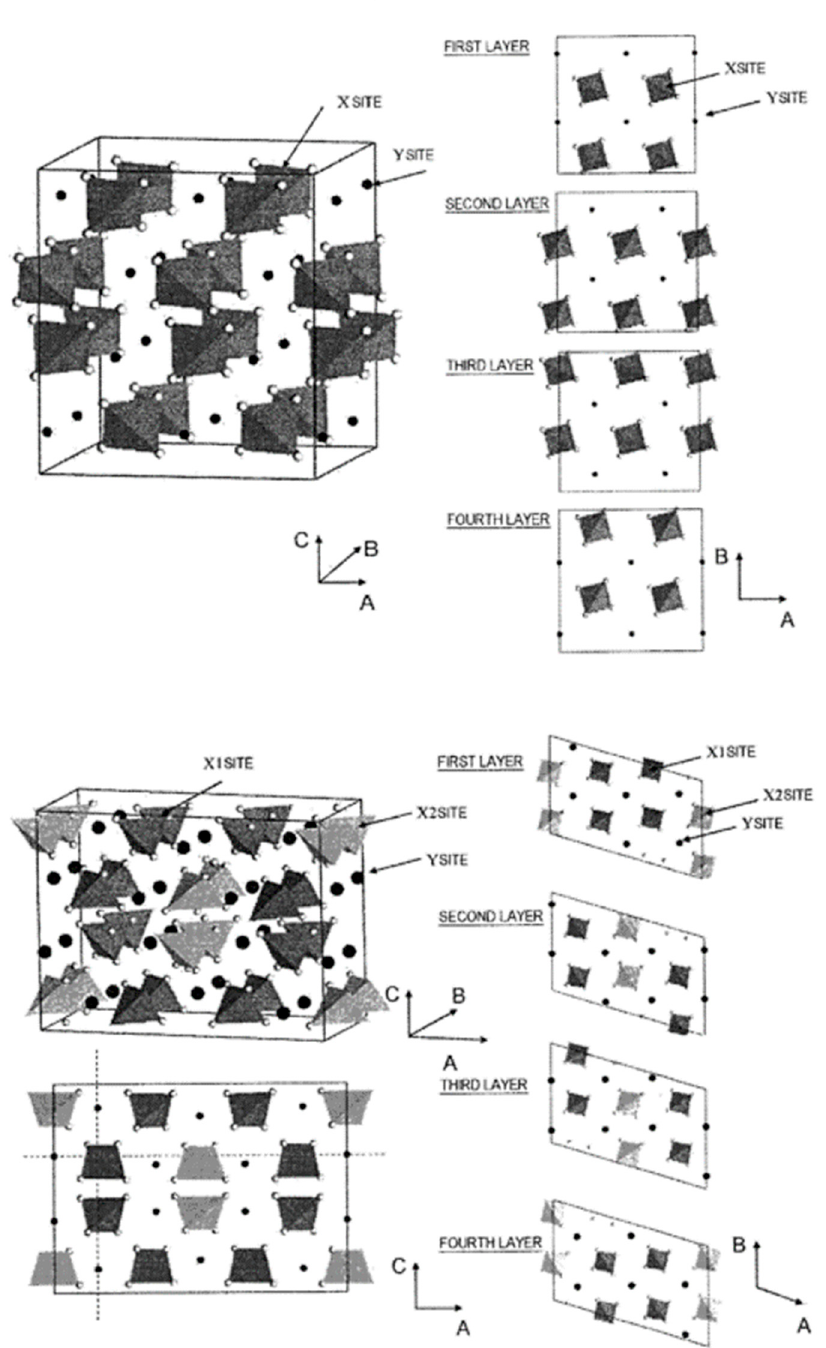
Figure 1. Schematic representation of the disordered ( top ) and ordered ( bottom ) Bi 3 FeMo 2 O 12 phases. Source [30].